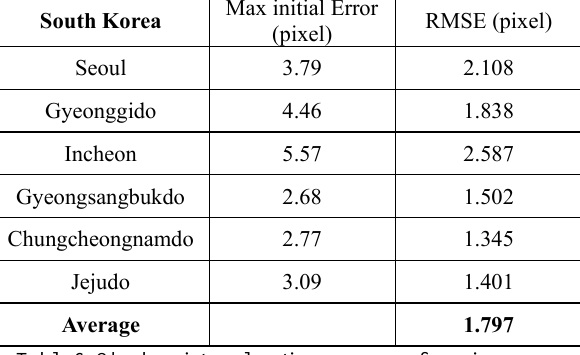
Table 6. Check point geolocation accuracy of precise sensor model (South Korea).